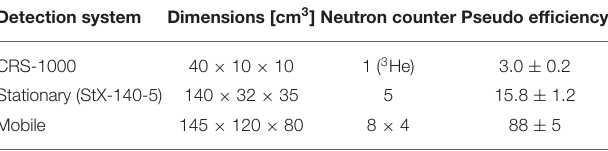
TABLE 1 | Key properties of the mobile and stationary detection system presented in this study and the commonly used CRS-1000. Detection system